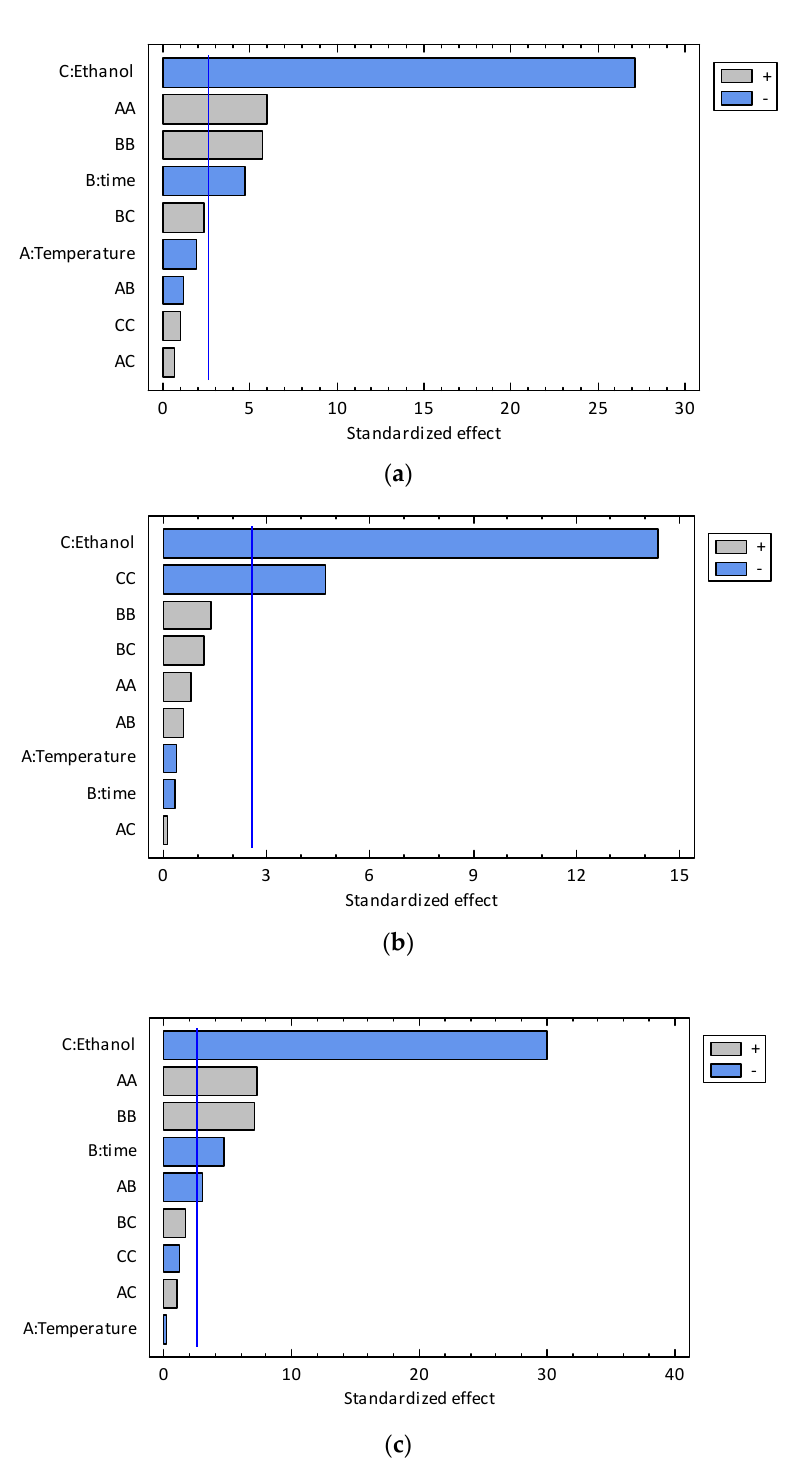
Figure 2. Pareto charts for TPC ( a ), TFC ( b ), and TAA ( c ) for the conventional extraction experiments.